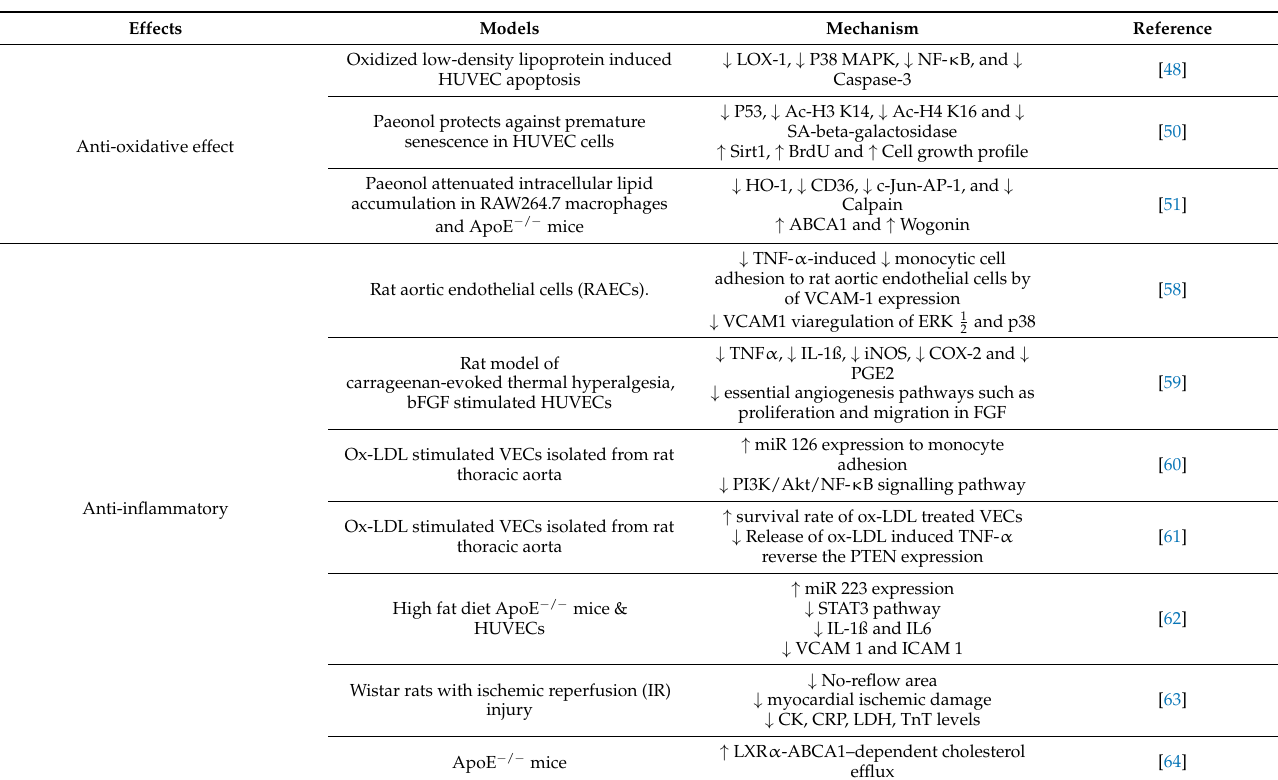
Table 1. Mechanism of action of Paeonol in cardiovascular